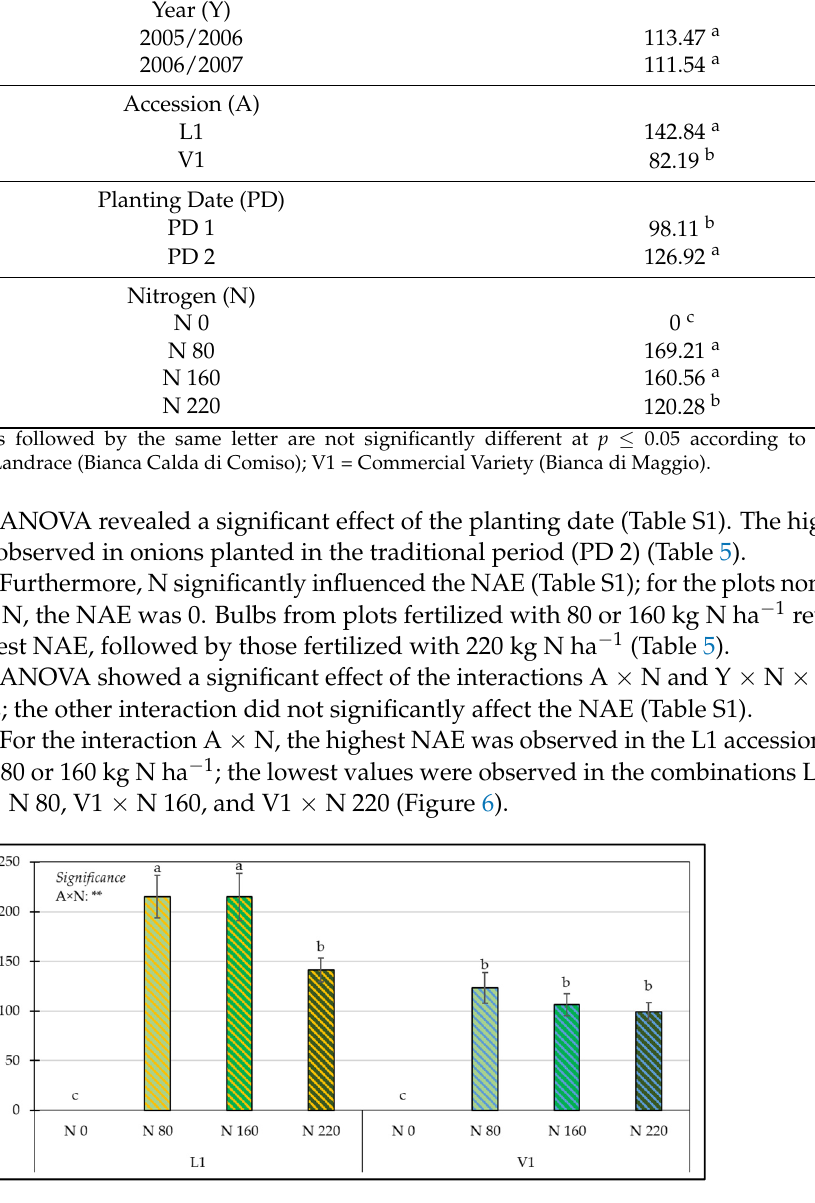
Figure 6. Influence of the interaction A × N on the NAE (nitrogen agronomic efficiency). Means with the same letter are not significantly different at p ≤ 0.05 according to Tukey’s test. Bars represent the standard error. ** = significant at p ≤ 0.01; A = Accession; N = nitrogen; L1 = Landrace (Bianca Calda di Comiso); V1 = Commercial Variety (Bianca di Maggio).